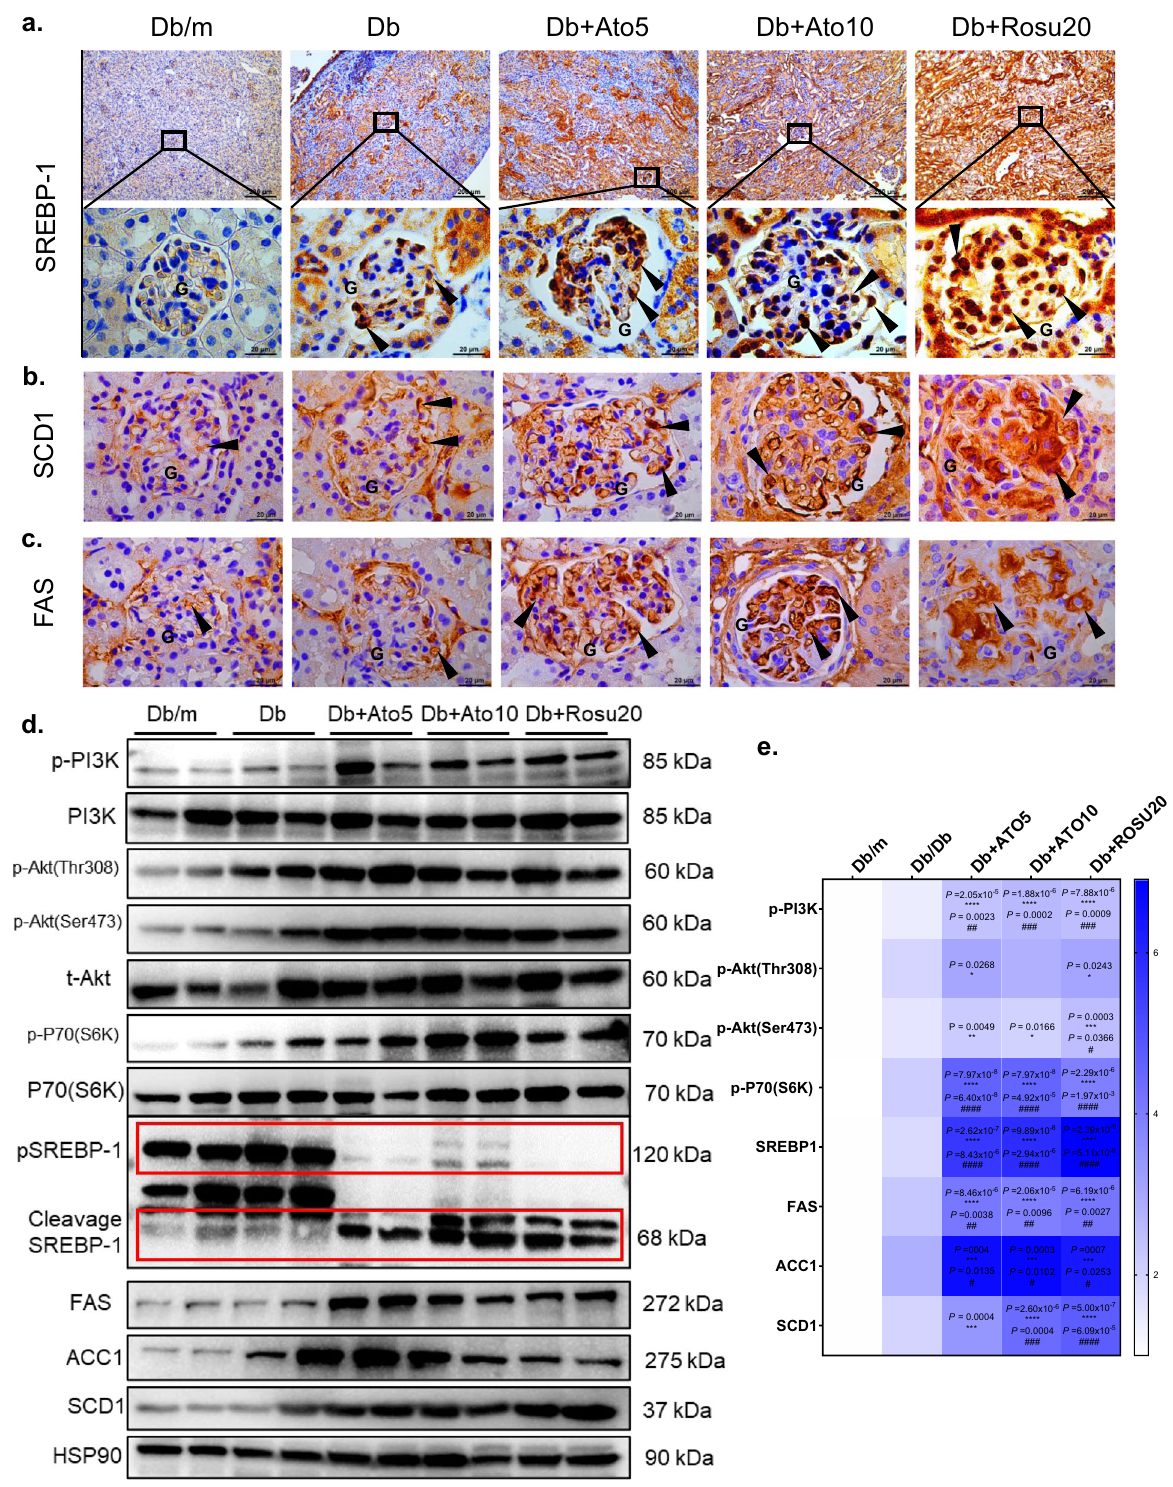
Fig.7|Long-termstatinsadministrationactivatedSREBP-1throughPI3K/Akt/ mTOR pathway in the db/db mice. All mice were ~50 weeks